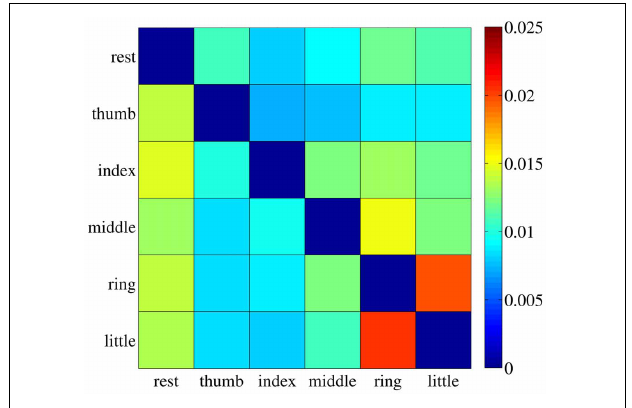
FIGURE 7 | The general safety matrix. Each entry of the matrix, s ij , is the safety index between clusters C i and C j , that is the ratio of the maximal standard deviation of cluster C i and the Euclidean distance between the two clusters. Values averaged over all subjects.